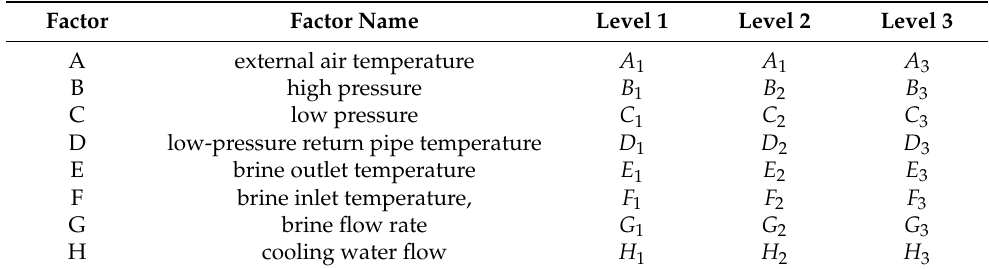
(cid:0) (cid:1) 2 1 × 3 7